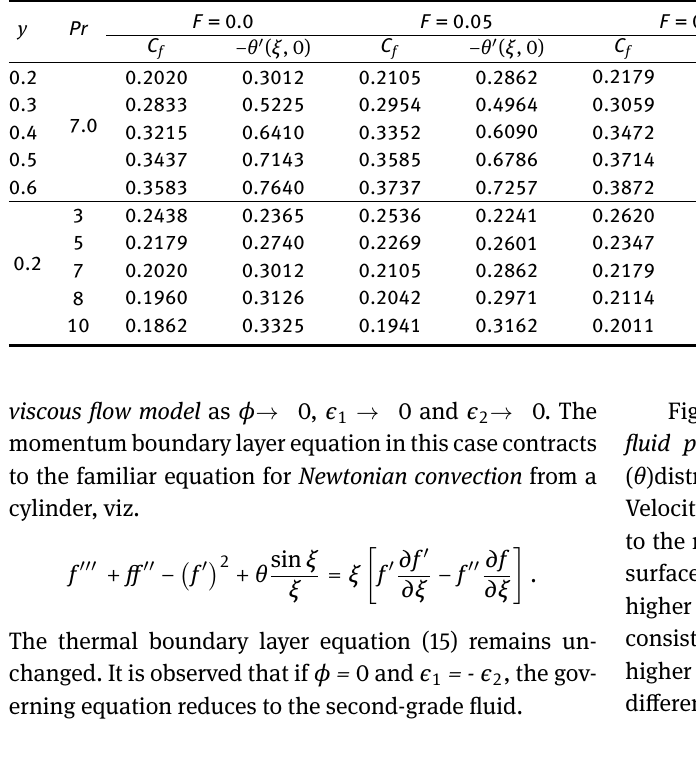
Table 3: Values of C f and − θ (cid:48) ( ξ , 0) for different γ , Pr and F ( φ = 0.1, ϵ 1 = 0.3 = ϵ 2 , ξ =